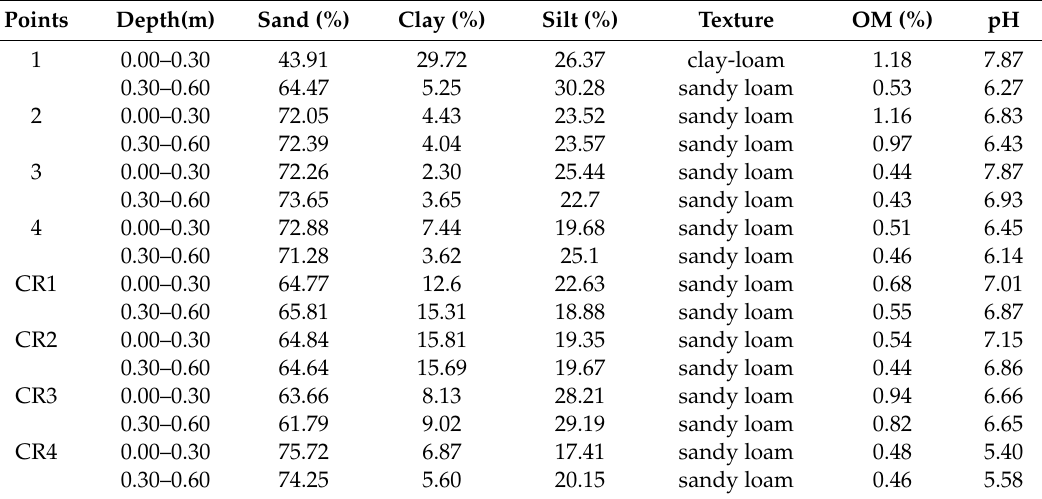
Table 1. Soil analysis in the studied